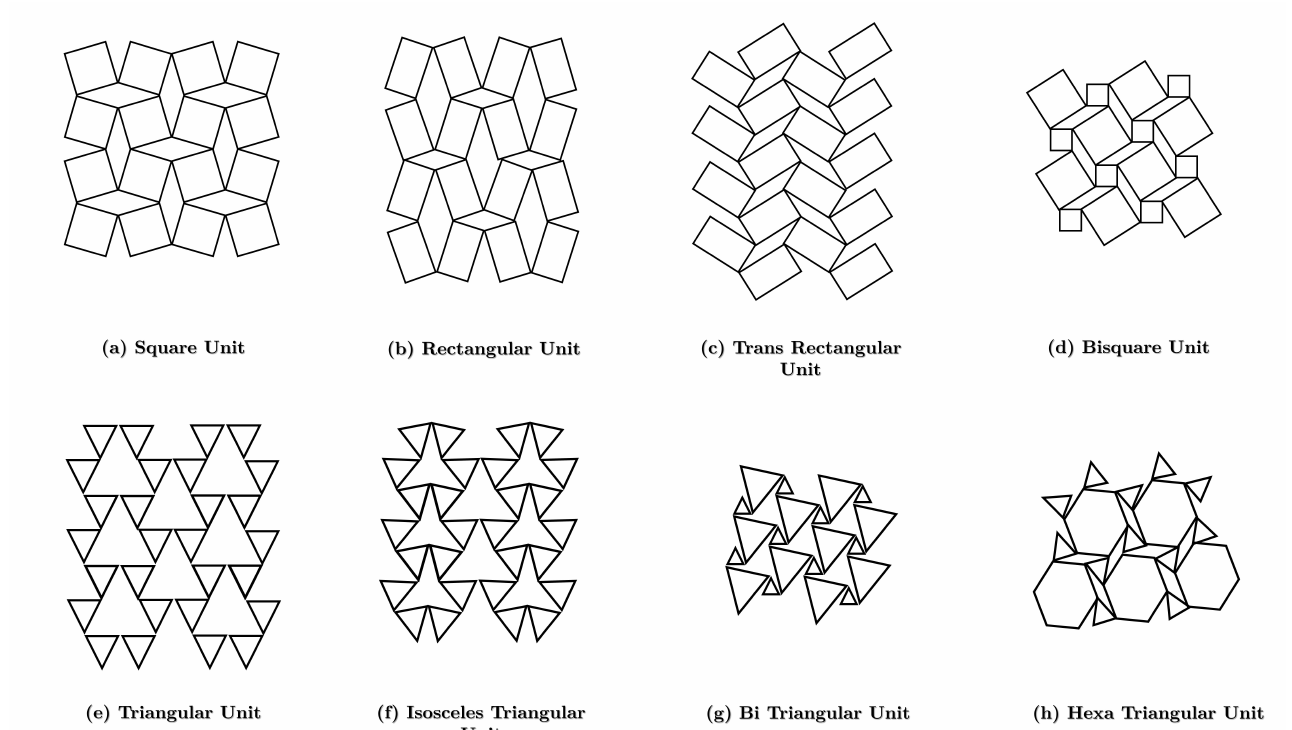
Figure 14. AXSs Rotating units: ( a ) square; ( b ) rectangular; ( c ) trans-rectangular; ( d ) bisquare; ( e ) triangular; ( f ) isosceles triangular; ( g ) bi-triangular; and ( h )